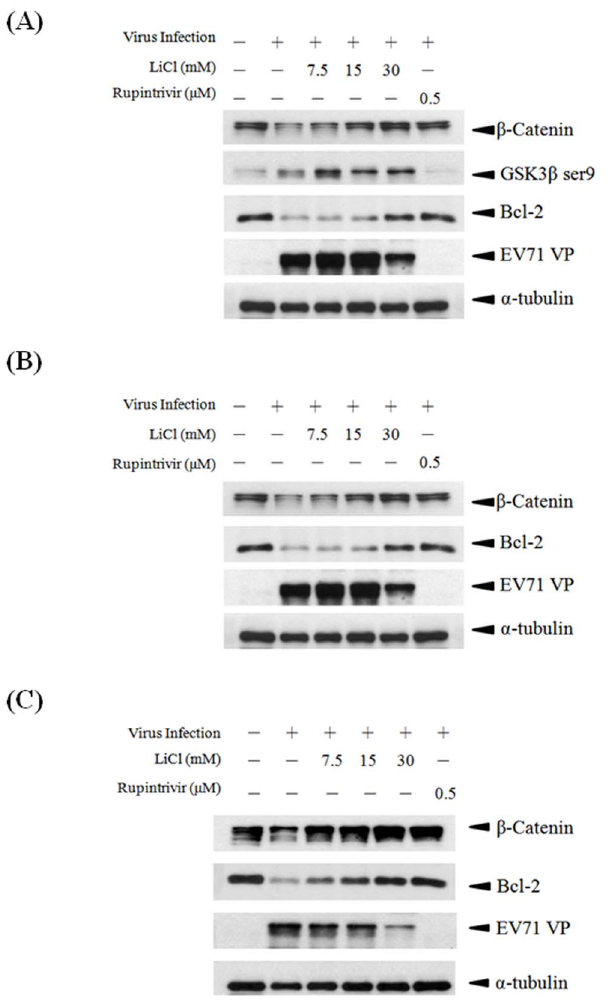
Figure 2. LiCl inhibits EV-A71 replication in SF268 cells (A), (B) and SH-SY5Y cells (C). Cells were infected with EV-A71 (moi 0.5), and various concentrations of LiCl were added to the infected cells after viral adsorption time. Lysates collected At 8 h ( A ) and 72 h ( B, C ) post- infection were analyzed with immunoblotting. Rupintrivir was em- ployed as a positive control because it can effectively inhibit EV-A71 replication. Measurements were made in three independent experi- ments.